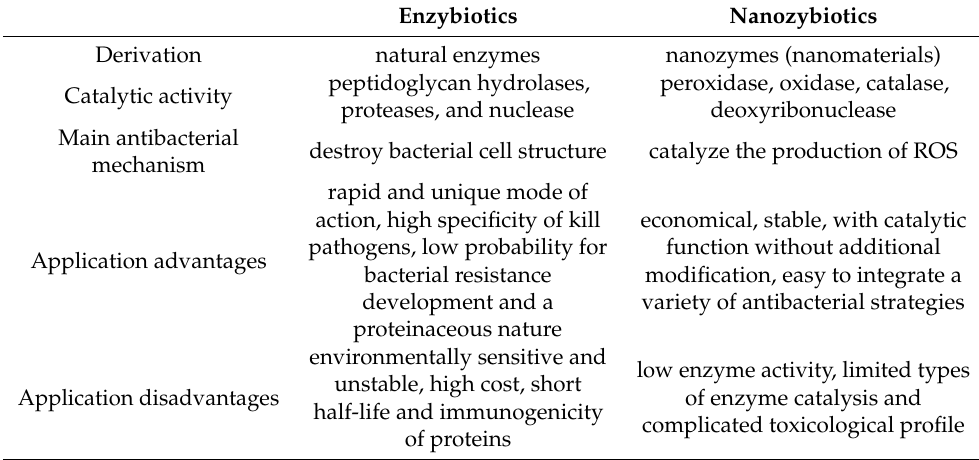
Table 2. Comparison between enzybiotics and nanozybiotics for antibacterial application.